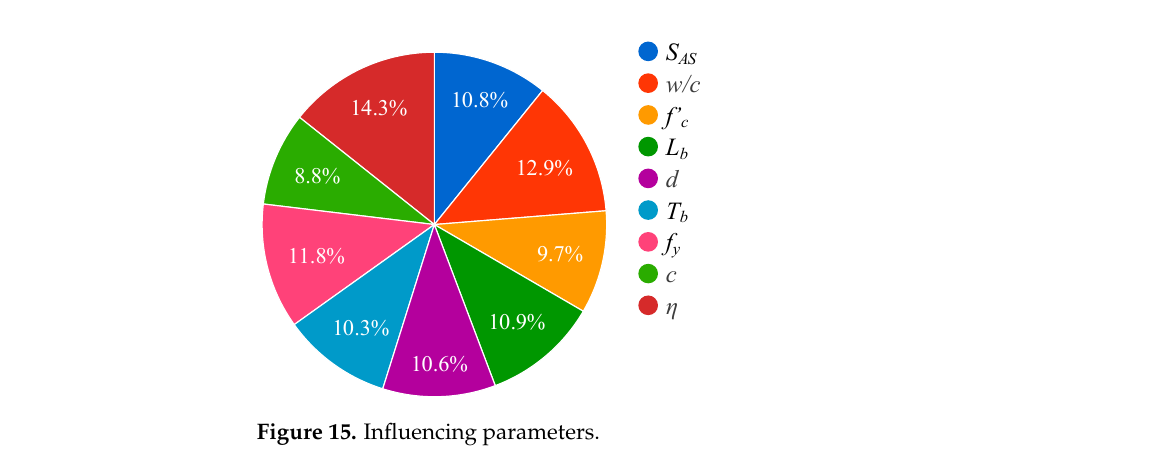
28 of 33 Figure 14. Taylor diagram for all groups; ( a ) Group-I, ( b ) Group-II, ( c ) Group-III, ( d ) Best model from each group, and proposed SVM and ANN models. The green dotted line represents the values of the original experimental dataset. If the proposed model patterns are close to the observed patterns, it means that they are similar in terms of their standard deviation, their correlation value is high, and their RMSE value is close to zero. In Figure 14a, all the models in Group-I fell into the standard devi- ation range of 0.061 to 5.515 and the R-range of 0.053 to 0.146. The overall performance of Group-I models was very poor. Moreover, as illustrated in Figure 14b,c, the performance of Group-II and III models was also poor. The ANN model is directly over the green dot- ted line in Figure 14d, while the rest of the analytical models from other groups are located far from the green dotted line, except the SVM model. The SVM model is inside the green dotted line because its standard deviation value was lower. The graphical representation of the Taylor diagram also confirms the reliability and accuracy of the developed ANN model. 5.4. Relative Importance